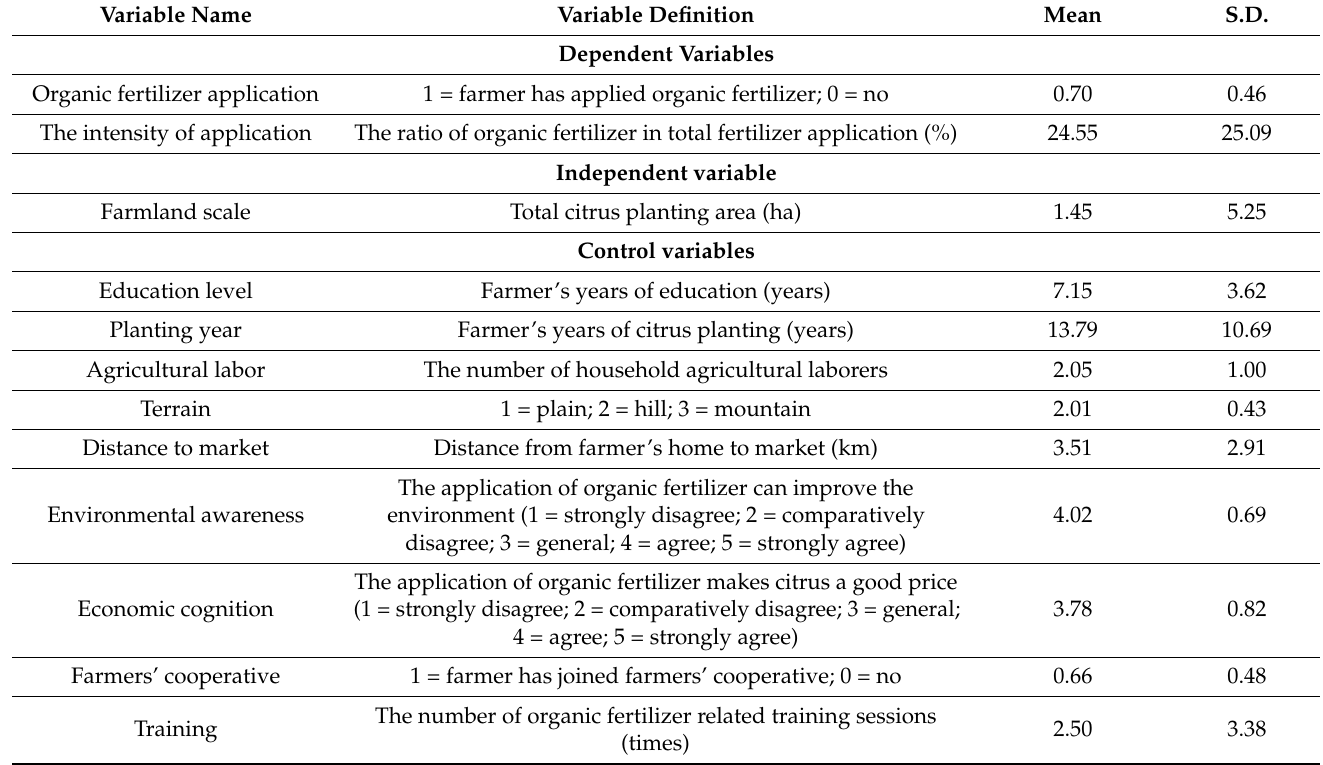
Table 1. Variable definition and statistical descriptive